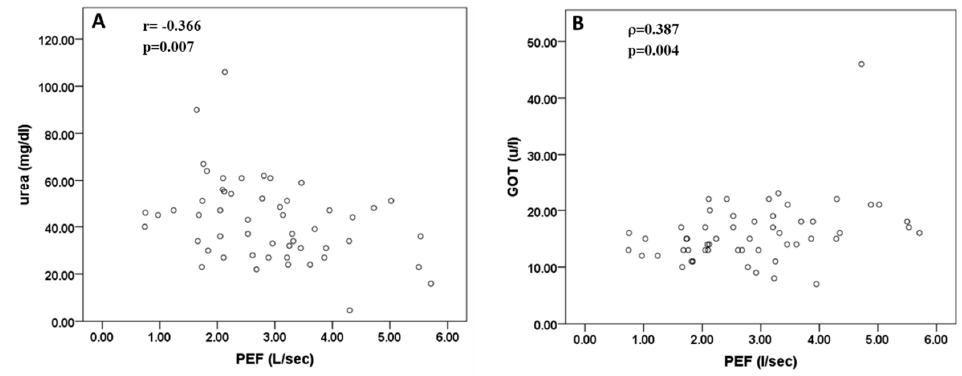
Figure 4. Correlation between PEF and urea ( A ) and GOT ( B ) concentration.